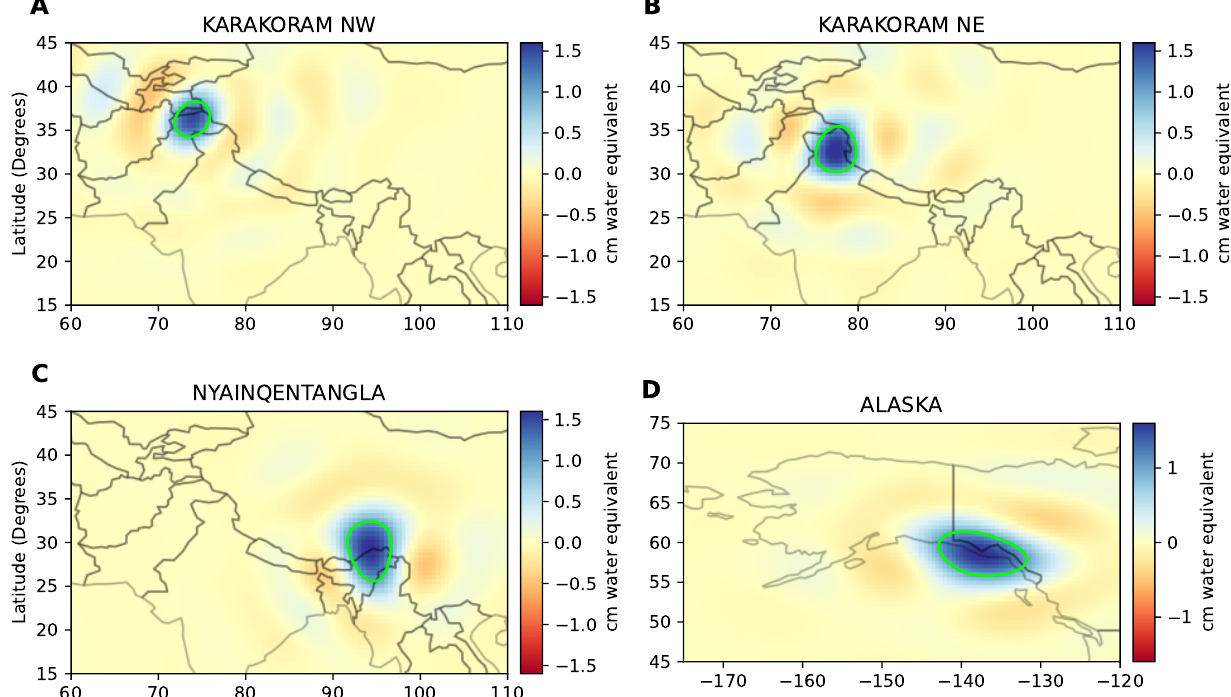
Figure 3. The sensitivity kernels [20] corresponding to the four test regions: northwest Karakoram ( A ), southeast Karakoram ( B ), Nyainqentangla ( C ), and Alaska ( D ). Note that the amount of ringing increases as the mascons approach the spatial resolution of GRACE harmonics (e.g., Karakoram), which is a fundamental trade-off when designing the configurations. The green line shows the 1.0 contour where the GRACE signal is being